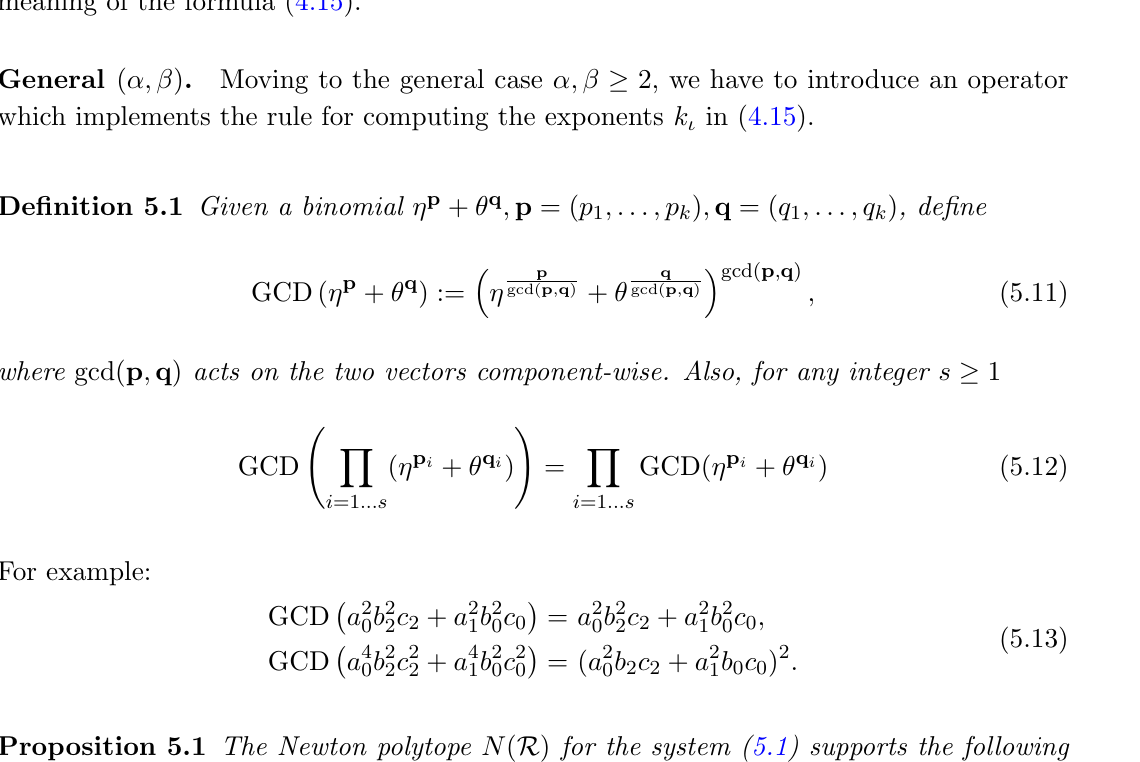
Therefore, one may search for all possible mixed decompositions of Q and compute the associated initial forms from the cell arrangement in each decomposition. This is the meaning of the formula